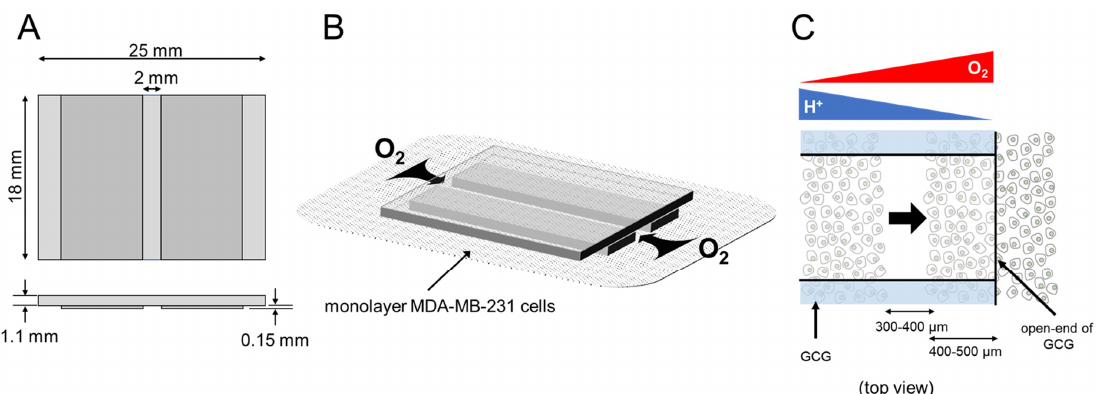
Figure 8. GCG. ( A ) Three thin glass plates were assembled into the GCG. ( B ) The GCG was gently placed onto the monolayer of MDA-MB-231 cells. The di ff usional supply of energy substrates such as oxygen to cells in the narrow channel of the GCG is restricted. Thus, cellular oxygen consumption produces gradients of oxygen concentration in the extracellular medium in the narrow channel. Washout of metabolites such as CO 2 / H + to the bulk medium is similarly restricted, and pH gradients are produced in the narrow channel. ( C ) GCG combined with wound-healing assay for cell migration. Gradients of oxygen and H + concentration are also illustrated. In the present study, we demonstrated a vectorial movement of MDA-MB-231 cells toward the open-end of GCG (i.e., higher oxygen concentration or lower H + concentration; indicated by the thick